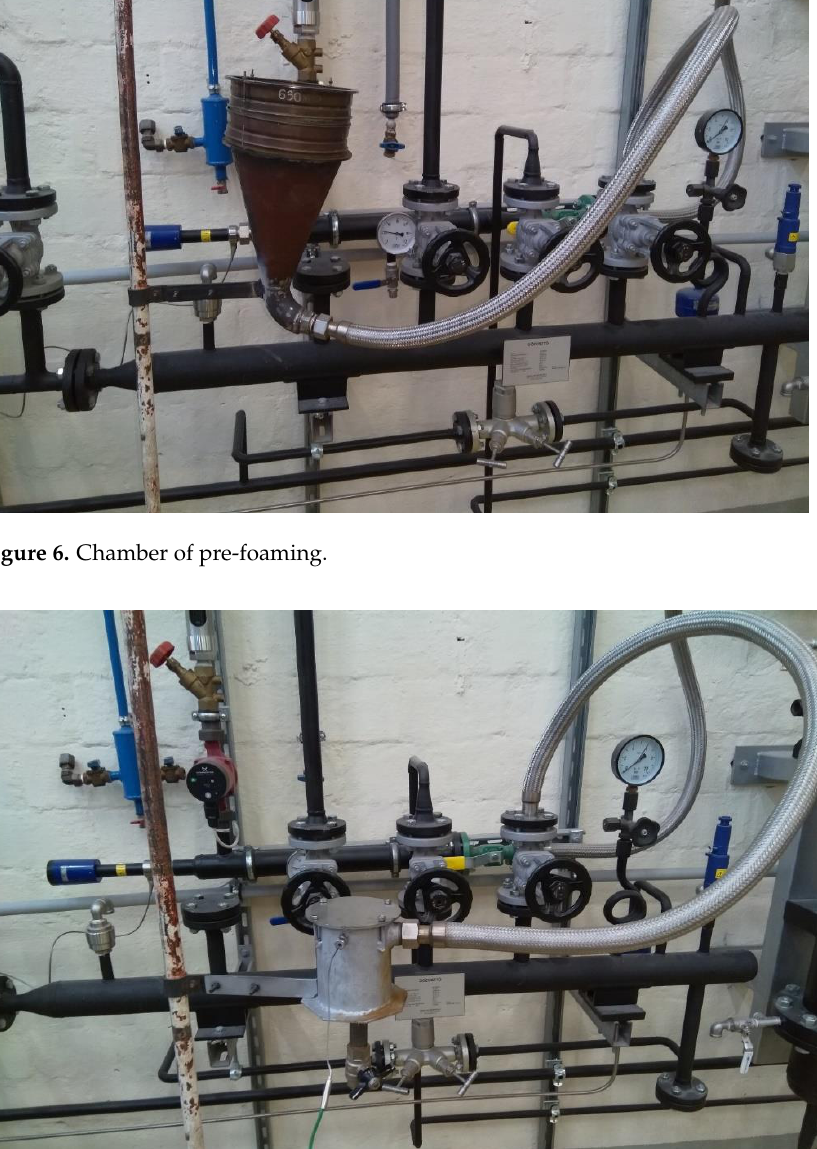
Figure 7. Chamber of manufacturing the sample piece.